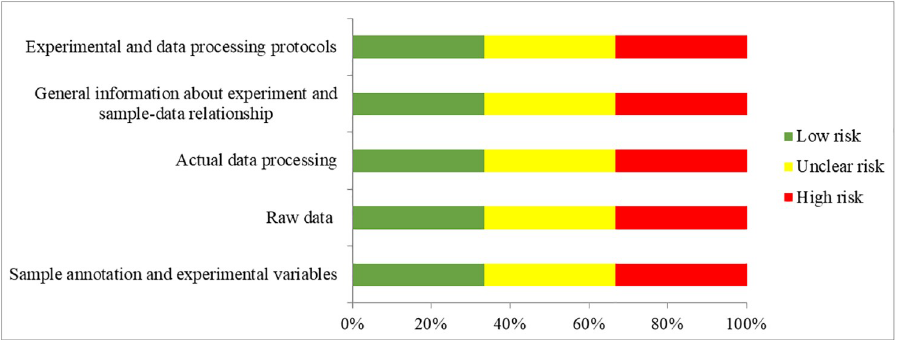
Fig 3. Quality assessment according to the MINSEQE guideline. Green bars, yellow bars and red bars respectively indicate the items were low risk, unclear risk and high risk.